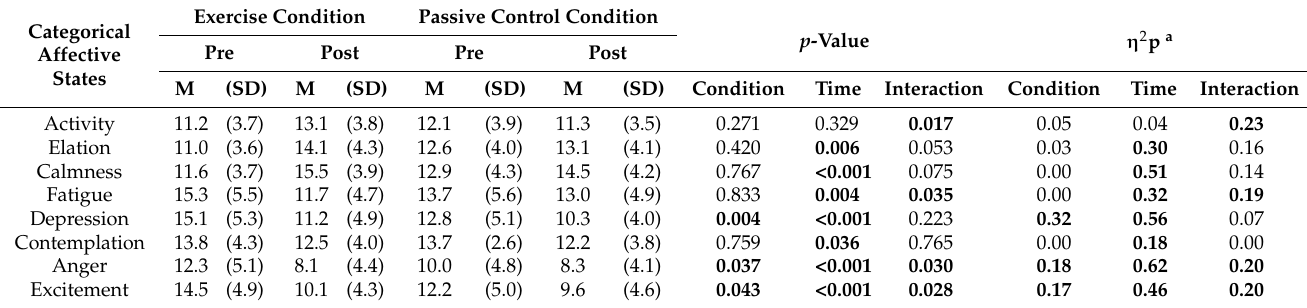
a : η 2 p: effect size partial η squared. Bold values indicate significant p -values/effect